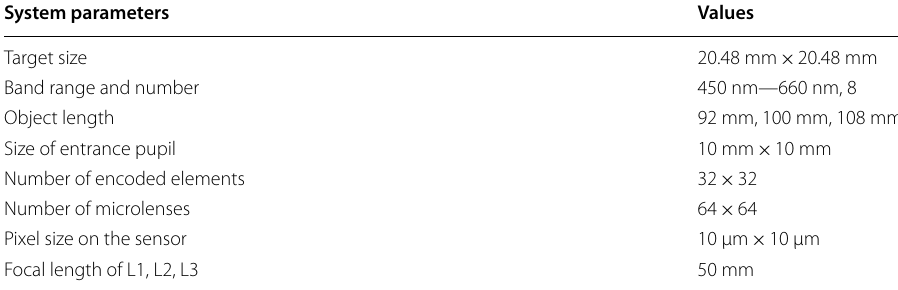
Table 1 The system parameters for simulations System